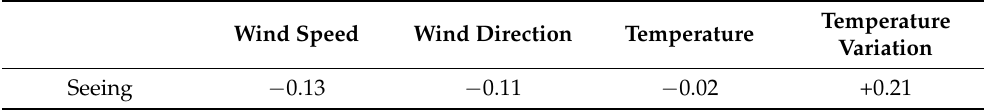
Table 3. Correlation coefficient for seeing and meteorological